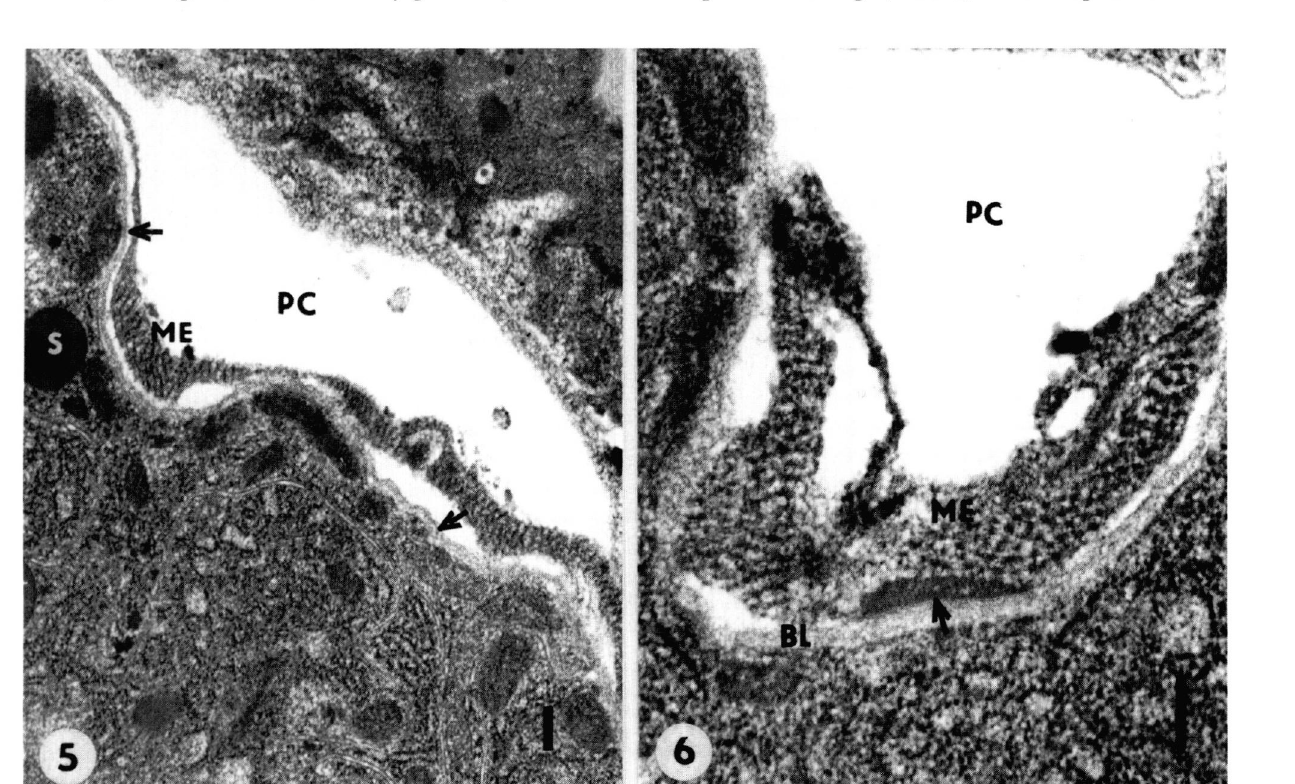
Figs 5-6. - Stichocyte of C. pteropbylli. Fig. 5. Muscle cells (ME) on the stichocyte surface. Arrows: basal lamina on the stichocyte surface, S: secretory granule, PC: pseudocoelom, scale bar = 200 nm. Fig. 6. Contracted part of the muscle cell (ME) with cross sectioned myofi laments and hemidesmosome (arrow), attaching this part to the stichocyte basal lamina (BL). PC: pseudocoelom, scale bar = 200